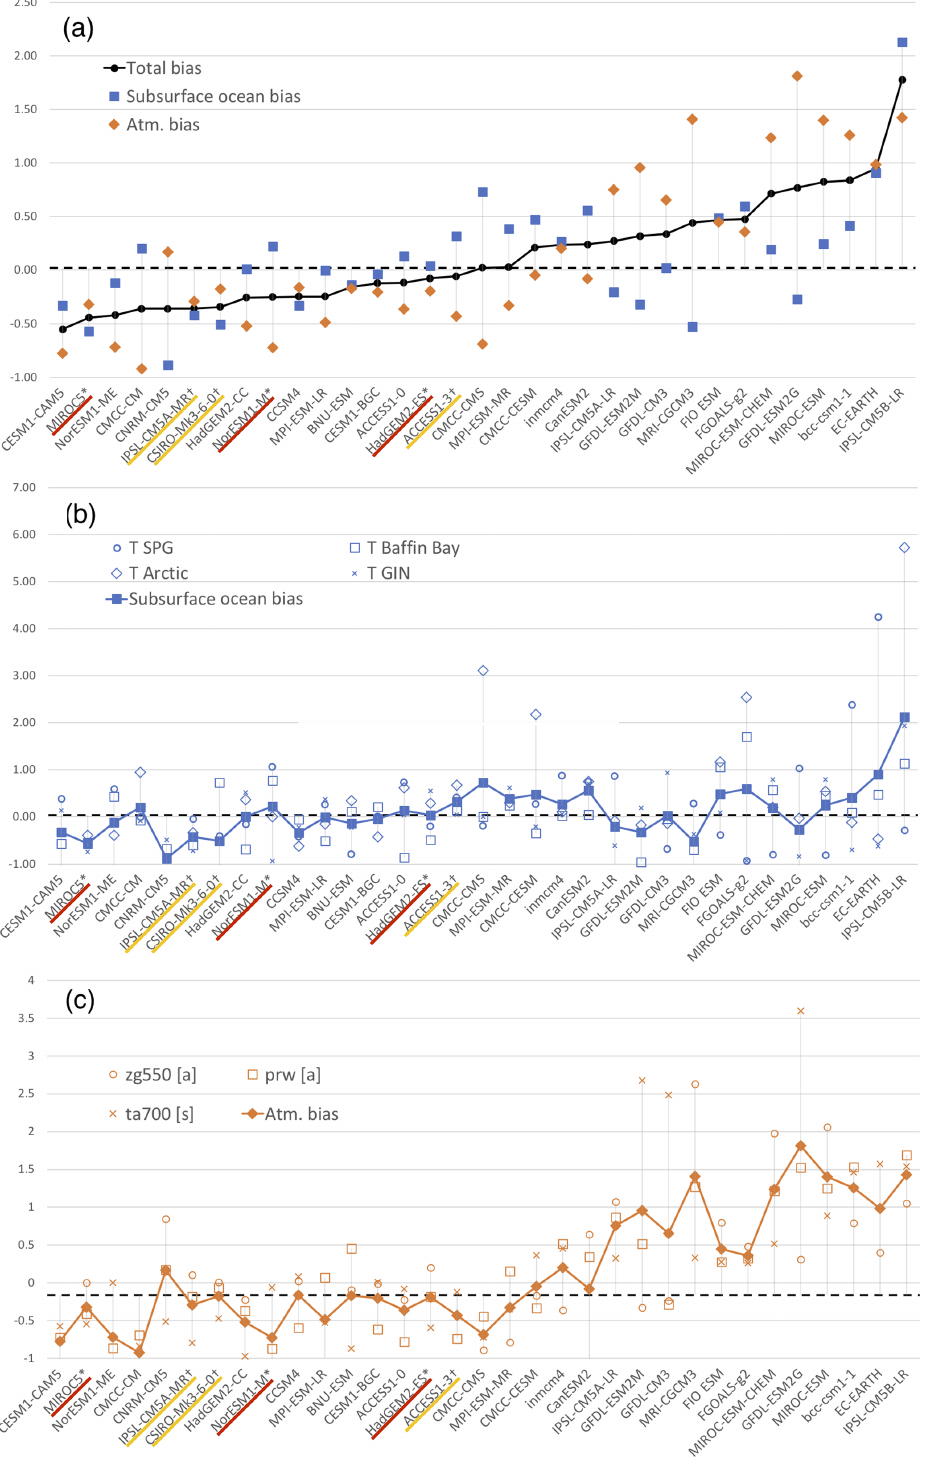
Figure 5. (a) Ranking of models according to total bias (black) over the Greenland domain, including the ocean (blue) and atmosphere (orange) contributions. (b) Breakdown of model performance in the ocean over the Greenland domain. (c) Breakdown of model performance in the atmosphere over the Greenland domain. Models are ranked according to total bias. Models selected in the top three (core) ensemble are underlined in red with an asterisk, and models in the top six (targeted) ensemble are underlined in color yellow with a †